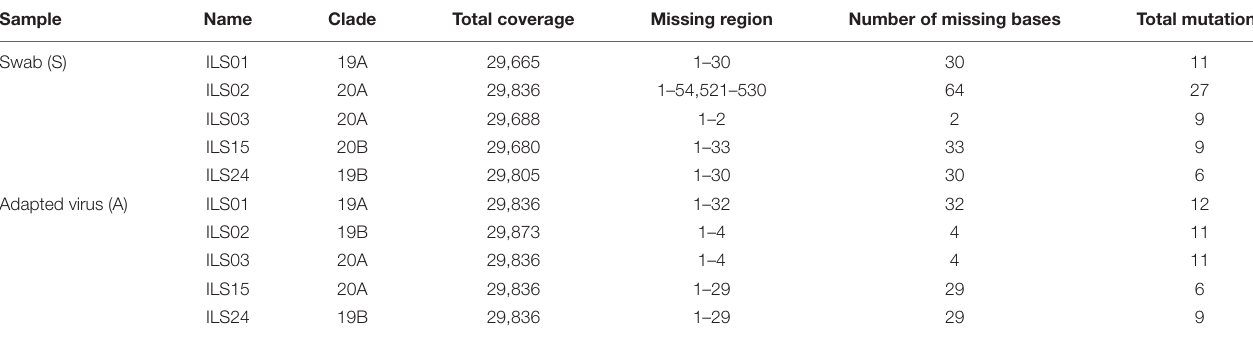
*Represents intergenic, non-synonymous, and synonymous mutations in all the isolates.